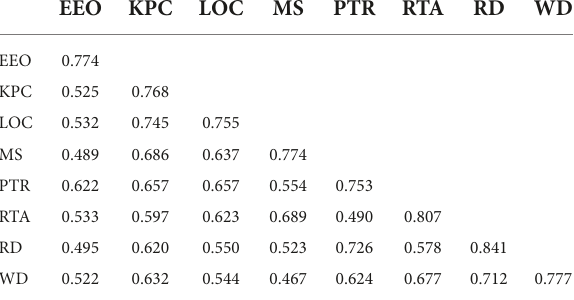
TABLE 4 Fornell–Larcker criterion.